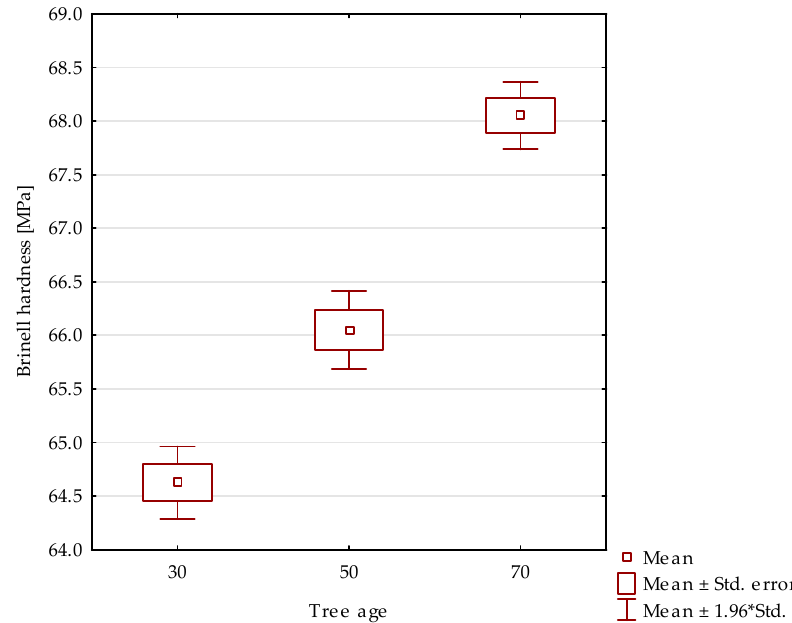
Figure 2. Mean values of wood hardness for trees of different ages.